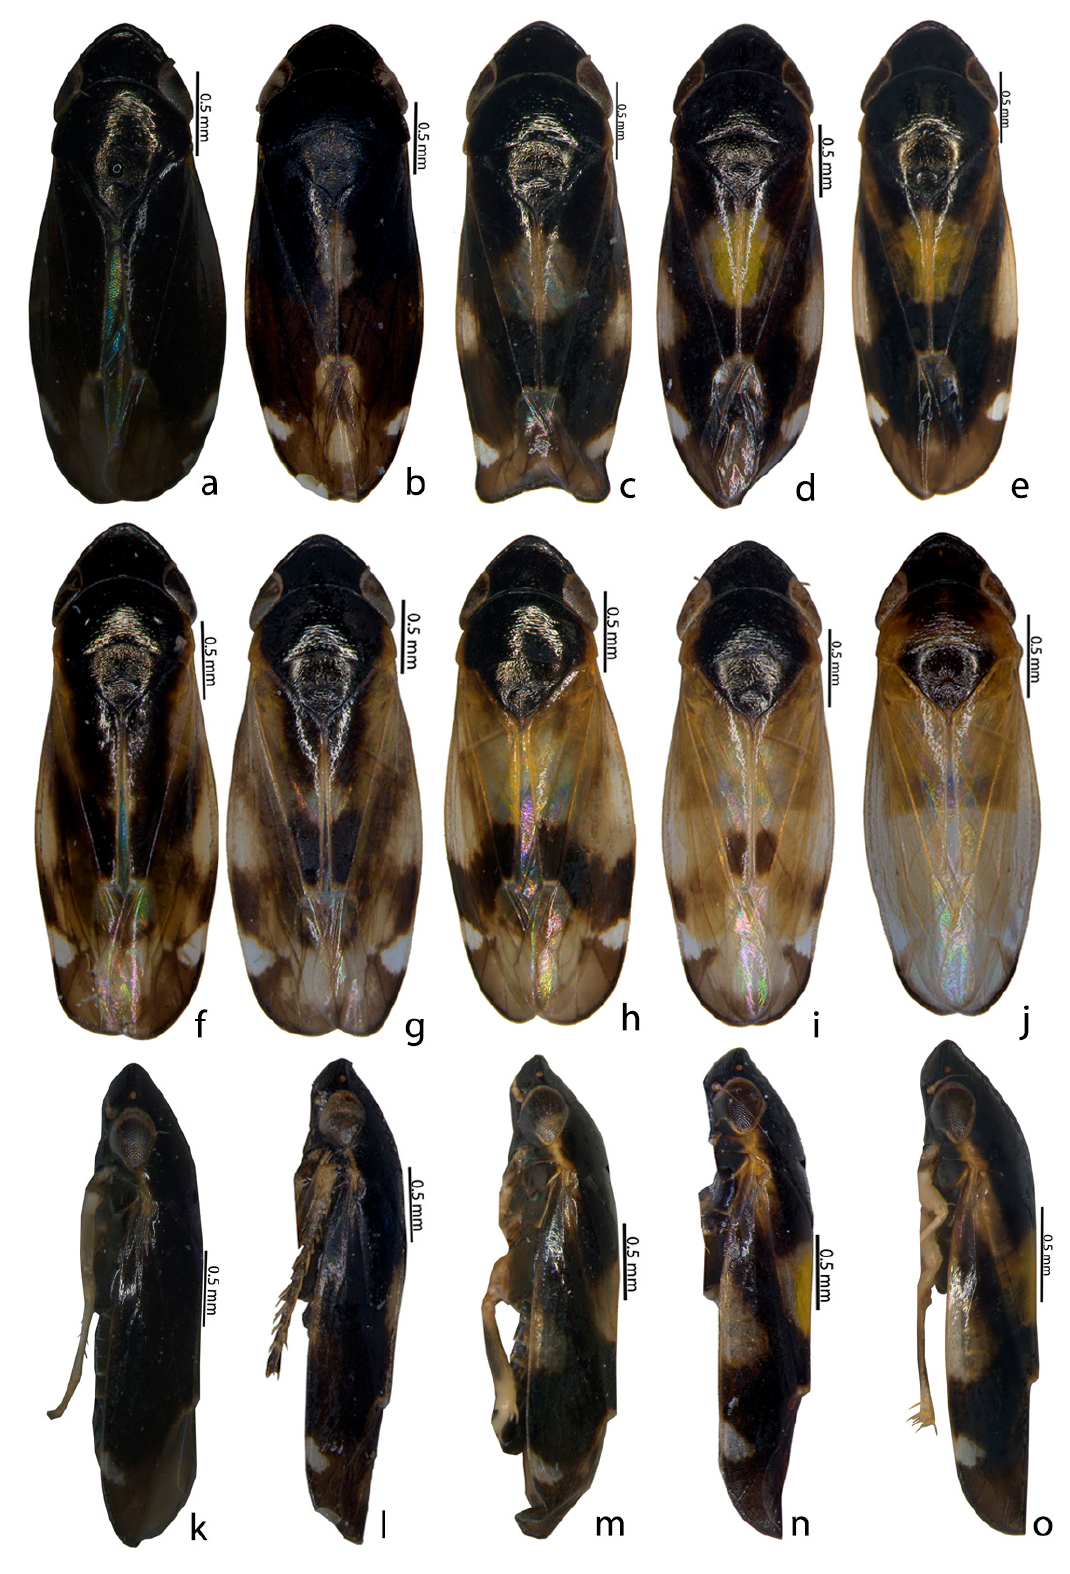
Figure 1. Colour polymorphism in Mukaria splendida Distant. ( a – j ) ♂ dorsal habitus; ( k – o ) ♂ lateral habitus.